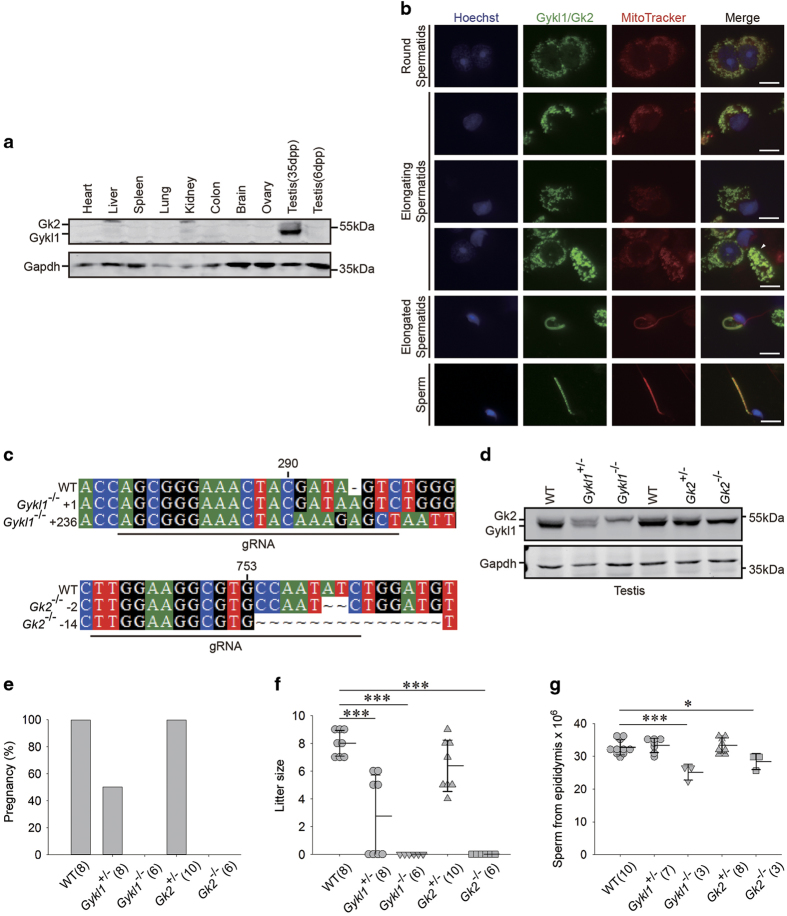
Mice deficient in Gykl1 or Gk2 exhibit reproductive defects. (a) Immunoblotting of Gykl1 and Gk2 protein in various tissues from C57BL/6J mice. dpp: day post partum. (b) Immunostaining of Gykl1 and Gk2 in round spermatids, elongating spermatids and spermatozoa pre-stained with 150 nM MitoTracker Red CMXRos. White arrow indicates the mitochondria in elongating spermatid. Scale bar: 10 μm. (c) Gykl1 and Gk2 KO mice were generated by CRISPR/Cas9-mediated genome editing. sgRNA sequences that target the Gykl1 and Gk2 loci are indicated here. Wild-type (WT) sequences are aligned against sequences from both mutant alleles for each mutant mouse. 'n' denotes the number of nucleotides inserted or deleted in the region. (d) Whole-cell extracts were collected from the testes of wild-type and Gykl1/Gk2 KO mice, and blotted with antibodies against Gykl1/Gk2. An antibody against GAPDH was used as a loading control. (e–g) The mean pregnancy rate (e), litter size (f) and sperm count (from the epididymis) (g) for wild-type vs homozygous (−/−) and heterozygous (+/−) Gykl1 and Gk2-deficient mice were determined and compared. Error bars represent s.d. Numbers in parentheses indicate sample size (n). Significance was determined by ANOVA. *P<0.05. **P<0.01. ***P<0.001.